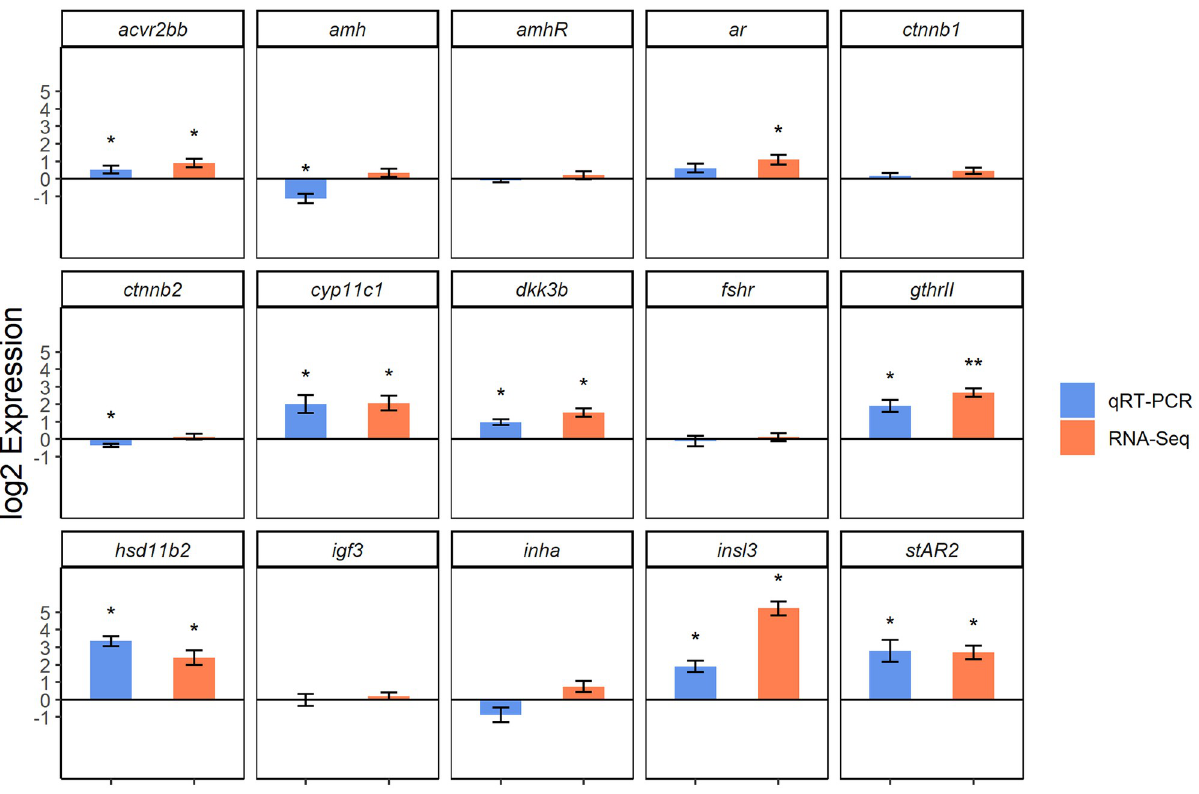
Fig 6. RT-qPCR expression of chosen genes from RNA-Seq. Testis expression of 15 genes measured with RNA-Seq and RT-qPCR of dominant fish compared to subordinate fish. Values are expressed as log2fold change +/- SEM. Significant differences for RT-qPCR data was determined via ANOVA. � = p <